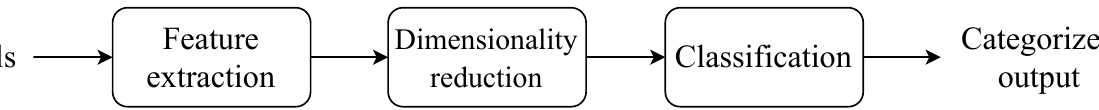
Figure 2. Symbolic diagram of the classification process